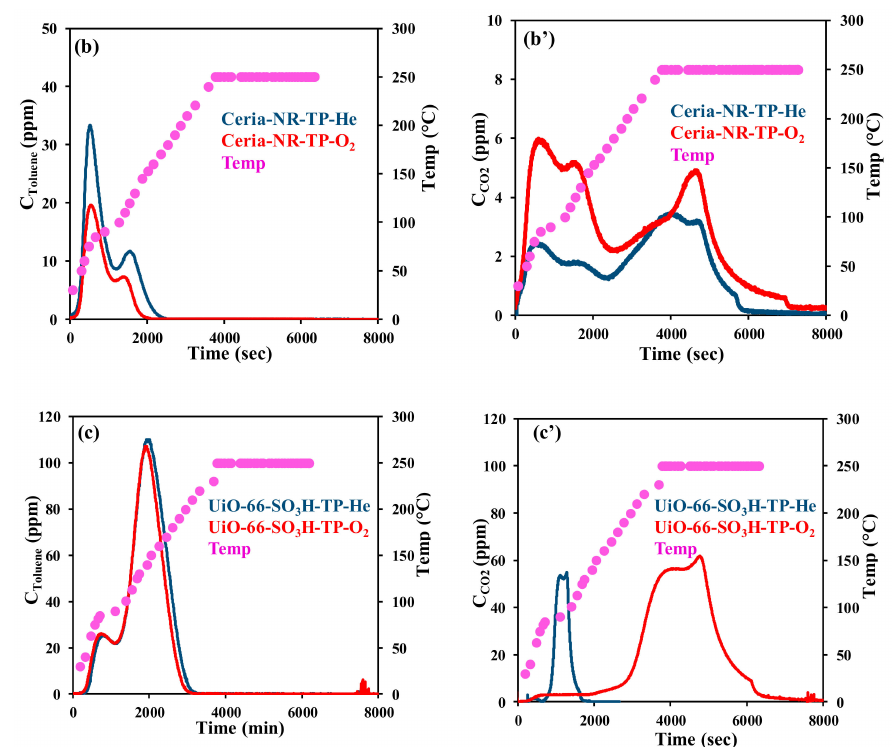
Figure 7. Toluene ( a , b , c ) and CO 2 ( a’ , b’ , c’ ) concentration evolution during temperature programmed reaction on Hopcalite ( a,a’ ), CeO 2 -NR ( b , b’ ) and UiO-66-SO 3 H ( c , c’